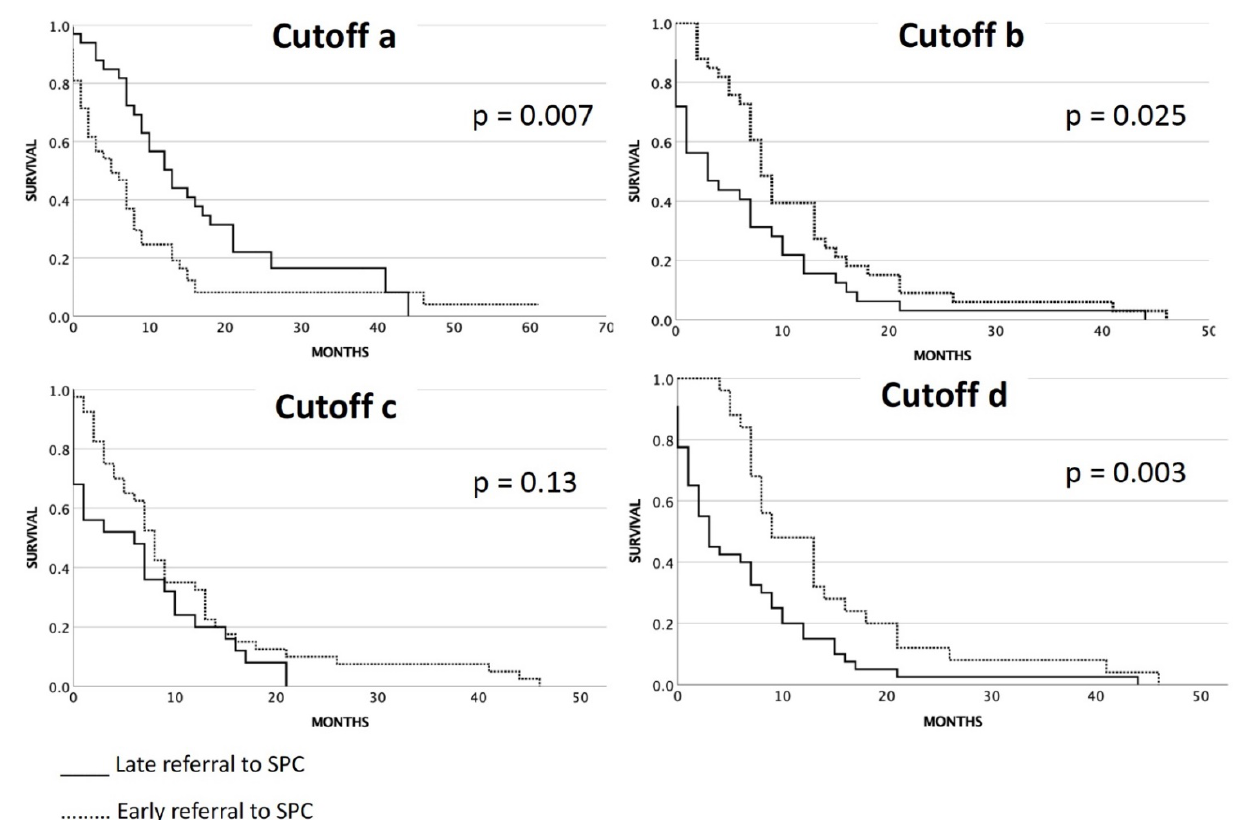
Figure 3. Overall survival related to early or late referral to SPC services with different cutoff values. Cutoff “ a ”: overall survival related to early (≤ 60 days) or late (>60 days) referral to SPC service after diagnosis; cutoff “ b ”: overall survival related to early (≥ 60 days) or late (<60 days) referral to SPC service before death from any cause; cutoff “ c ”: overall survival related to early (≥ 30 days) or late (<30 days) referral to SPC service before death from any cause; and cutoff “ d ”: overall survival related to early ( ≥ 130 days) or late (<130 days) referral to SPC service before death from any